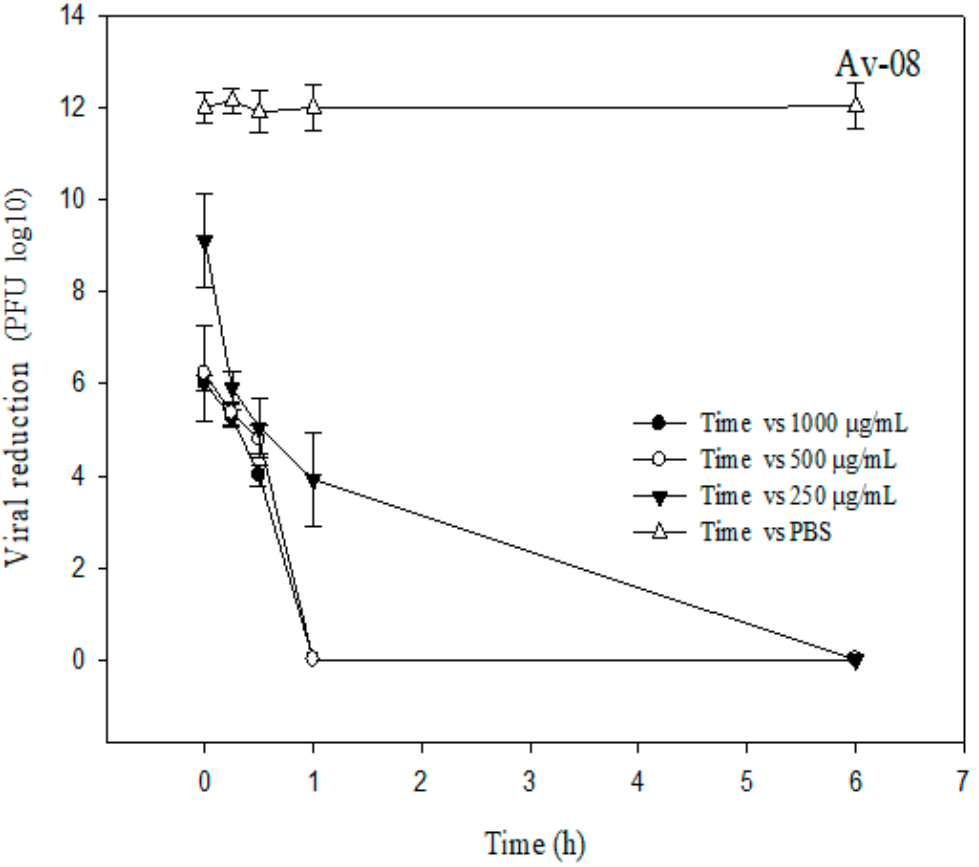
Figure 1. Reduction of Av ‐ 08 (PFU/mL log10) after treatment with AEE for various contact times (0, 15, 30, 60 and 360 min) at three concentrations (250, 500 and 1000 μ g/mL). The vertical error bars represent the standard deviation (SD). Phosphate ‐ buffered saline (PBS) is the control.